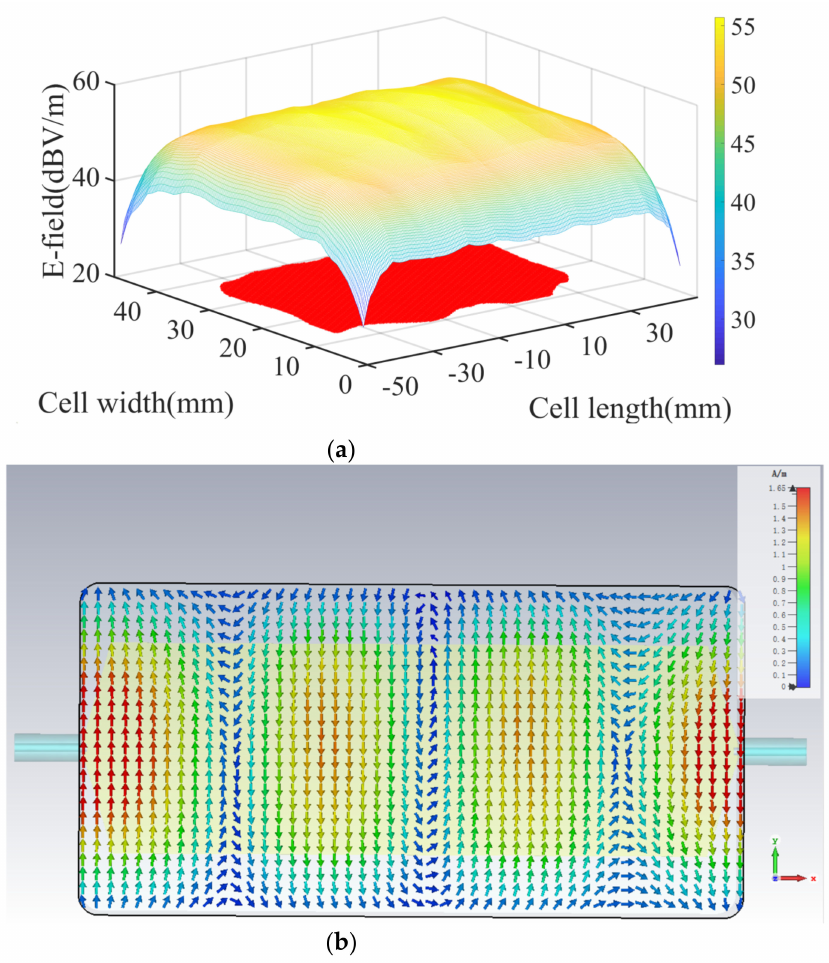
Figure 7. Field distribution at the top area of the long version IC-Stripline cell. ( a ) The electric field distribution (the red shaded area is the horizontal projection of the 3 dB uniform field region).